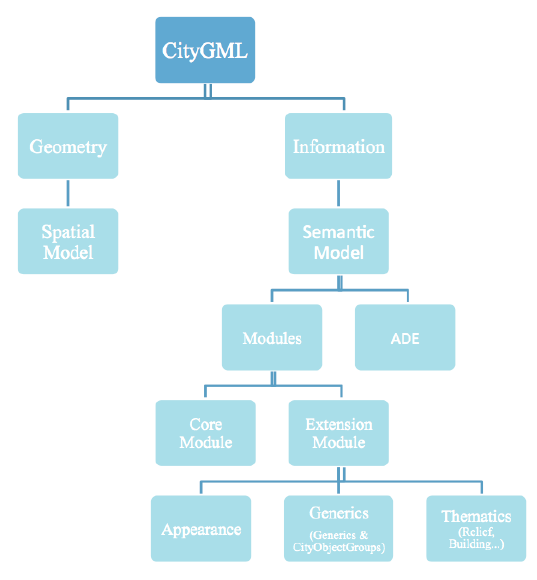
Figure 2. General view of the cityGML